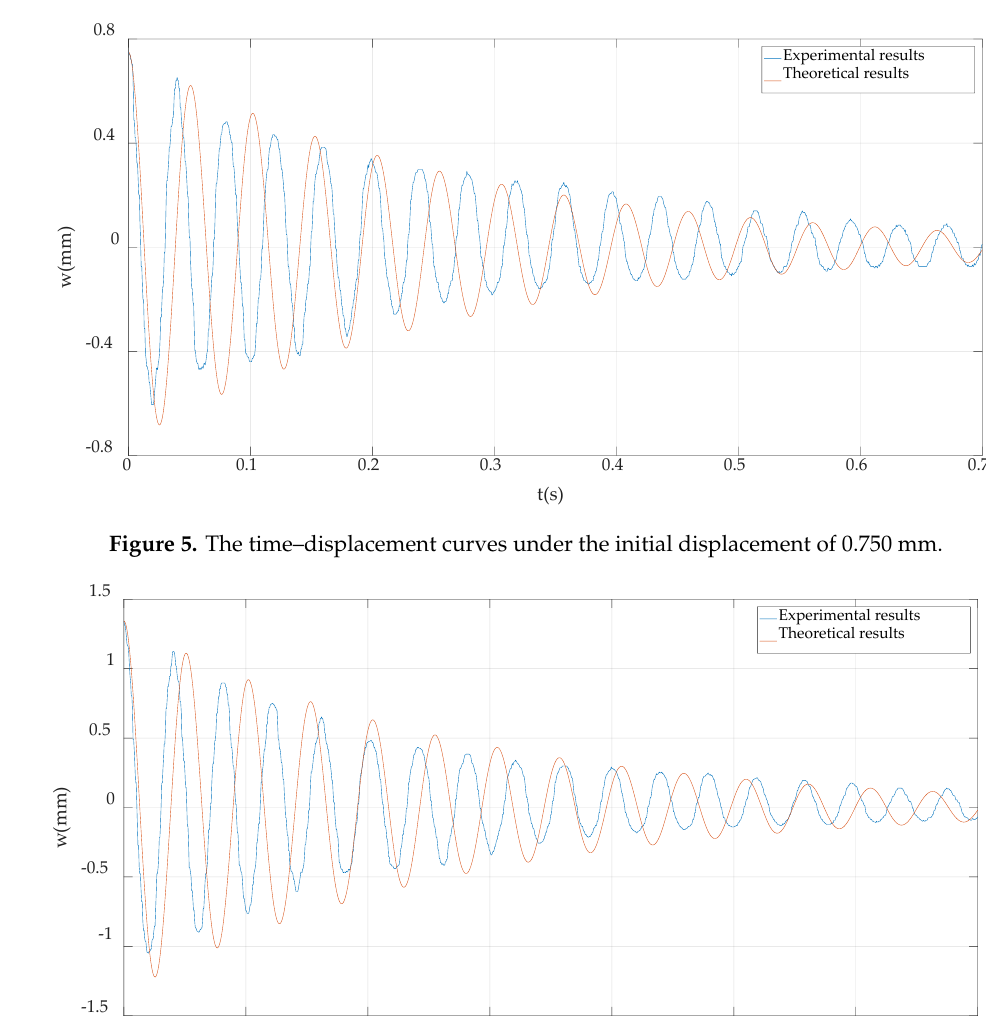
Figure 4. The time–displacement curves under the initial displacement of 0.475 mm.